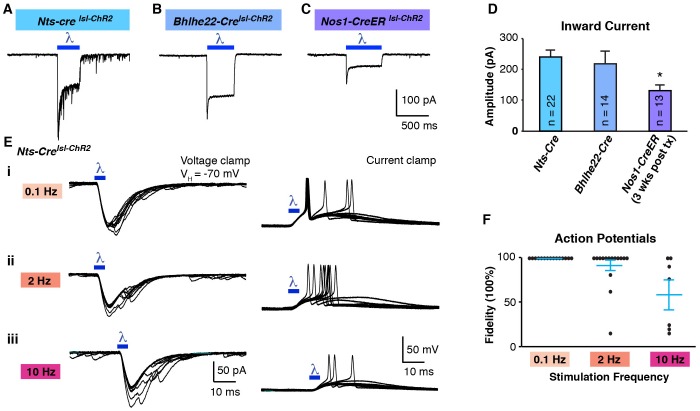
Optogenetic activation of spinal interneurons.(A–C) Representative traces of light-induced inward current in Nts-Cre (A), Bhlhe22-Cre (B) and Nos1-CreER (C) neurons expressing ChR2. (D) Quantification of light-evoked inward current. *p<0.05, One-way ANOVA followed by Tukey’s test. Data are mean + SEM. Number of recorded cells is indicated. (E) Inward current (left) and action potentials (right) in Nts-Cre neurons expressing ChR2 induced by a brief blue light pulse (blue bar; 5 ms) delivered 0.1 Hz (i), 2 Hz (ii) or 10 Hz (iii). Ten traces are superimposed to compare response jitter. (F) Fidelity of optogenetic-induced action potentials in Nts-Cre cells (expressed as percent) varies with frequency of stimulation. Black dots, individual cells; blue lines, mean ± SEM.